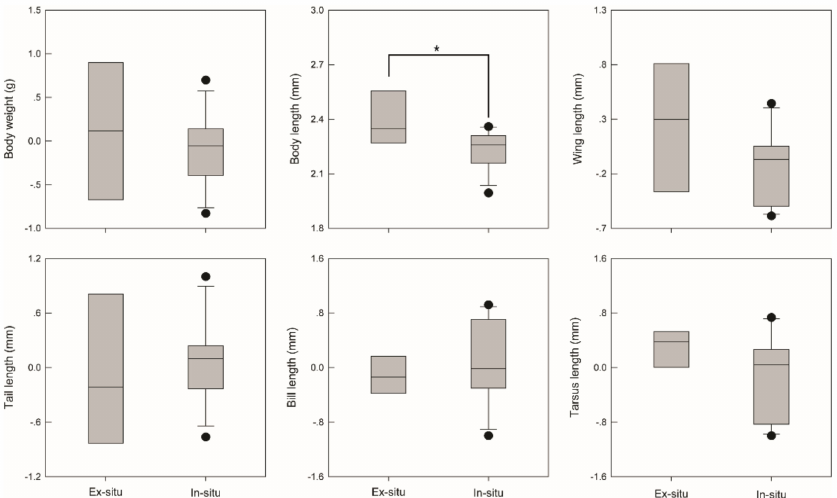
Figure 2. Comparing the morphological traits of foraging partners of Taxus chinensis (Pilger) Rehd across in-situ and ex-situ sites, Southeast China (ANOVA with data log transformed). Size e ff ects were removed in all cases by using residuals from the regressions on body length (snout–vent length, SVL). Values are presented as mean ± standard error. * p =